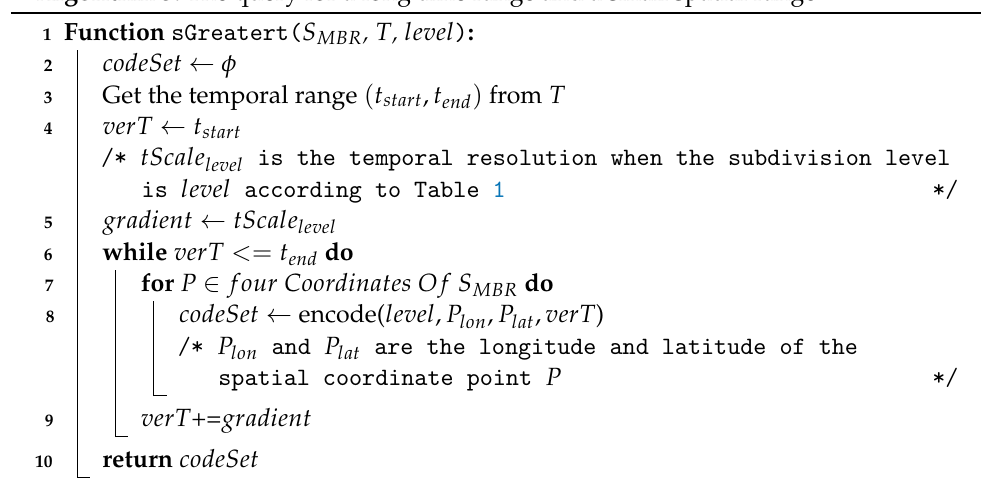
Algorithm 3: The query for a long time range and a small spatial